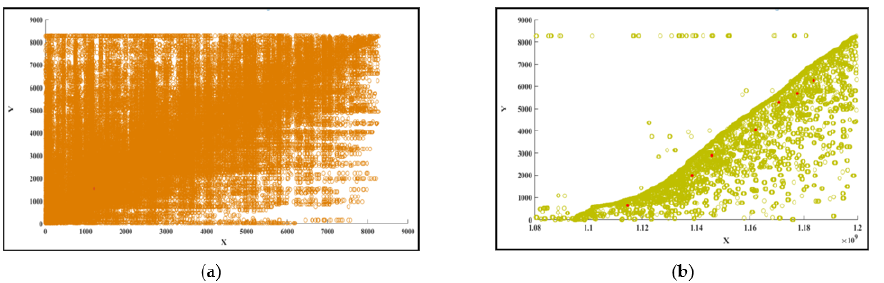
Figure 2. Visualization of the testbed data analysis. ( a ) Visualization of the unstructured data set, ( b ) Visualization of the structured data